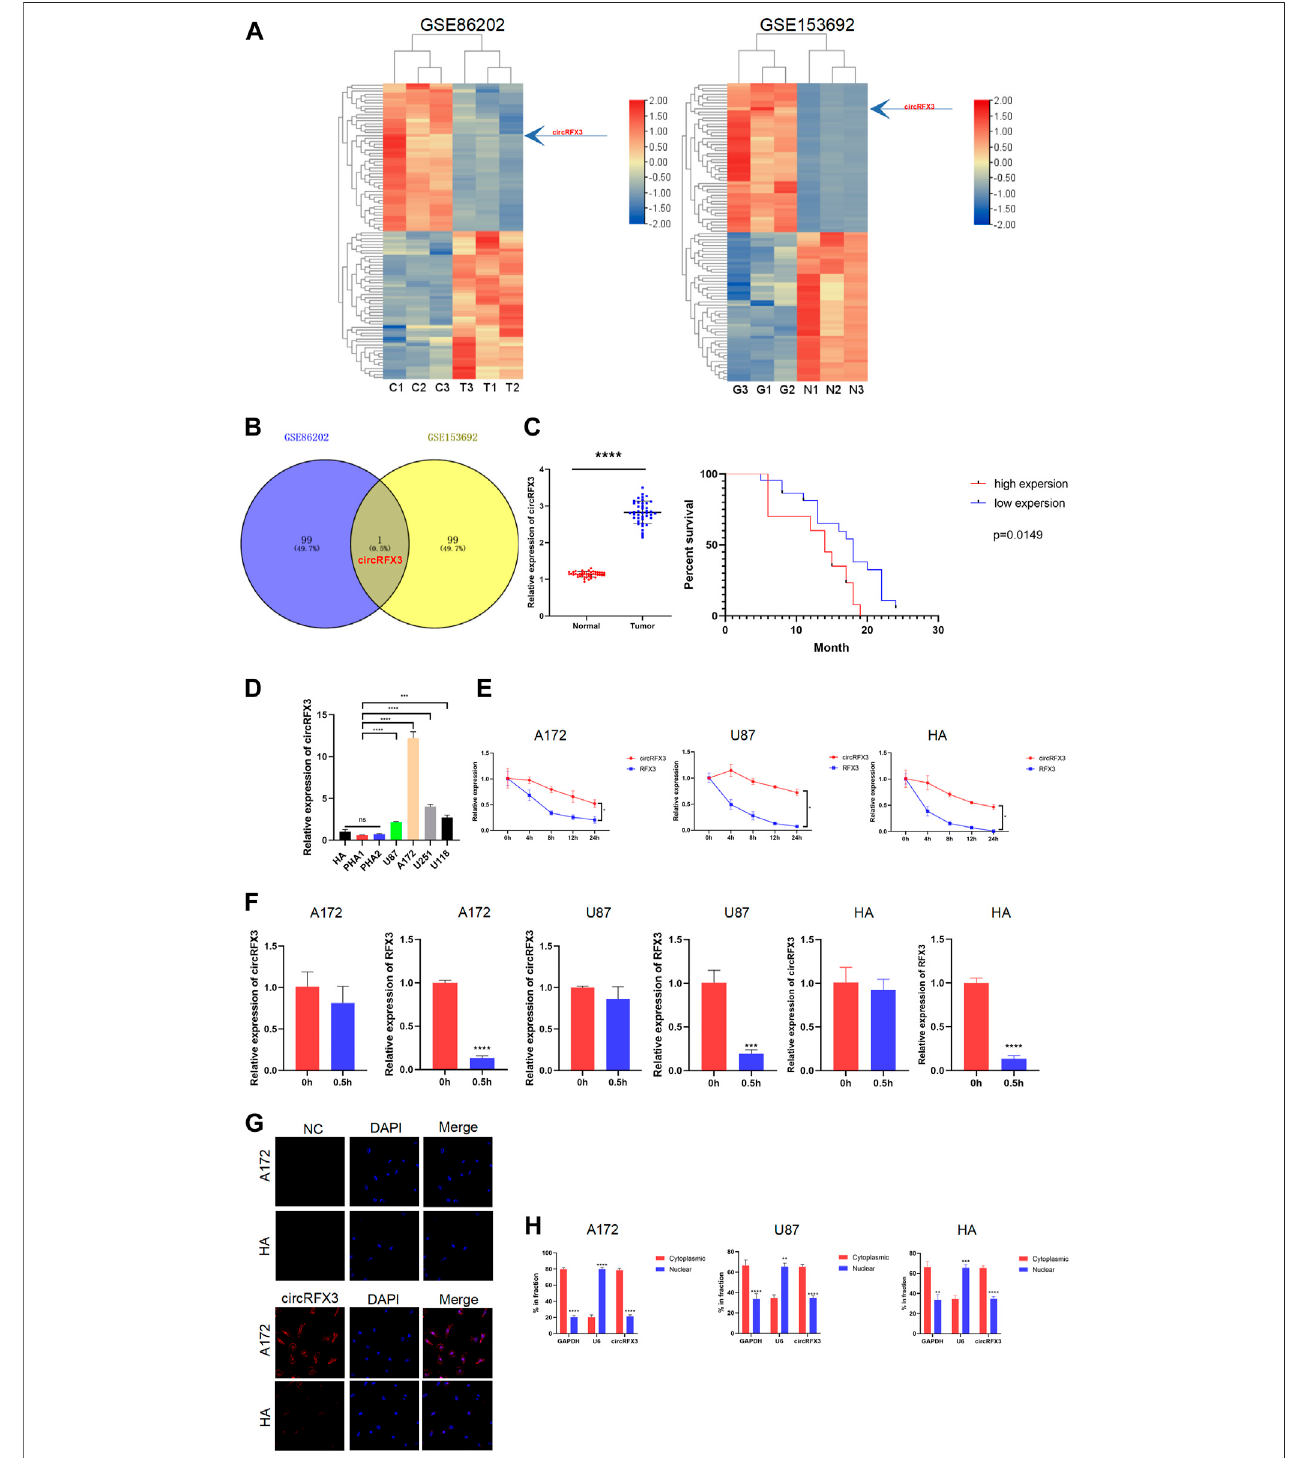
FIGURE 1 | circRFX3 was identi fi ed as increased in glioblastoma (GBM) clinical tissues and cell lines. (A) The heat maps of the top 50 upregulated and downregulatedcircRNAsintheGSE86202andGSE153692datasetswhichwereselectedwithbioinformaticstechnology. (B) VenndiagramshowingthatcircRFX3was the only intersection of the two groups. (C) The qPCR results showed that the circRFX3 expression level was much higher in clinical GBM tissues than in paired brain tissuessurroundingthetumors.**** p < 0.0001.TheexpressionlevelofcircRFX3predicted aworseprognosis. (D) circRFX3wasremarkablyincreasedinGBMcell lines and human astrocytes. (E,F) circRFX3 was more stable than RFX3 mRNA in both the A172 and U87 cell lines. (G) The fl uorescence in situ hybridization results showed that circRFX3 was located mainly in the cytoplasm. (H) The qPCR results showed that circRFX3 was located mainly in the cytoplasm of U87 and A172 cells. Statistical analysis was conducted with Student ’ s t -test. * p < 0.05.